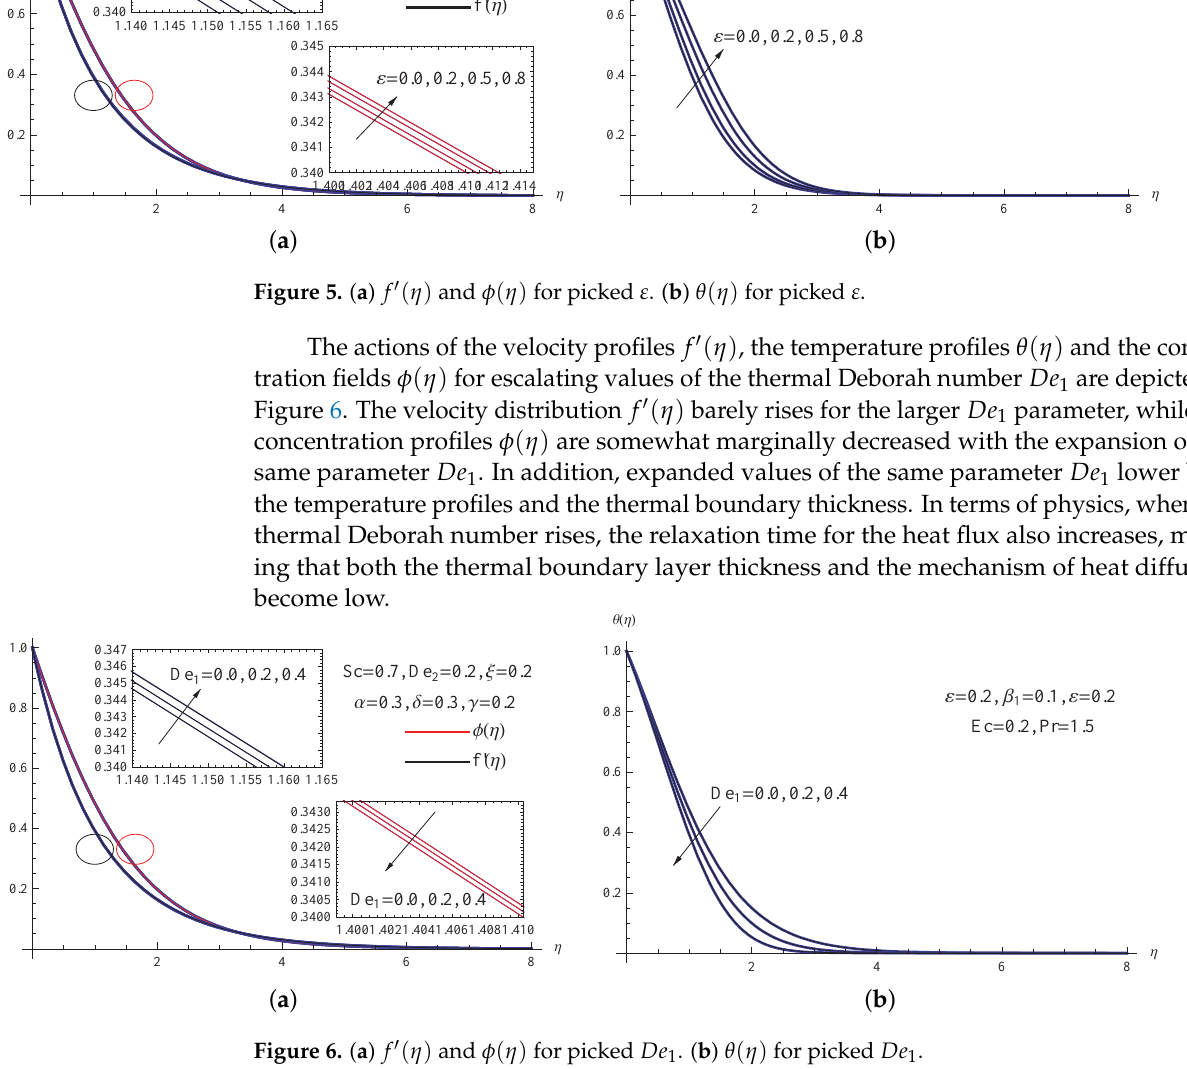
Figure 6. ( a ) f (cid:48) ( η ) and φ ( η ) for picked De 1 . ( b ) θ ( η ) for picked De 1